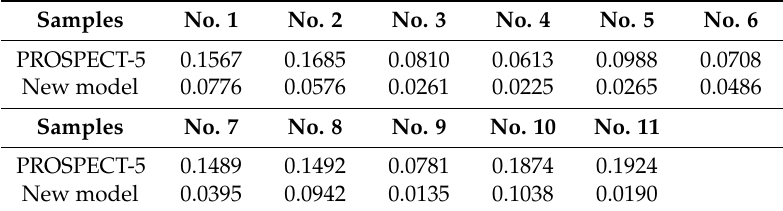
Table 4. RMSEs between the simulated spectra (PROSPECT-5 and the new model) and measured spectra of 22 groups of samples used for calibration.